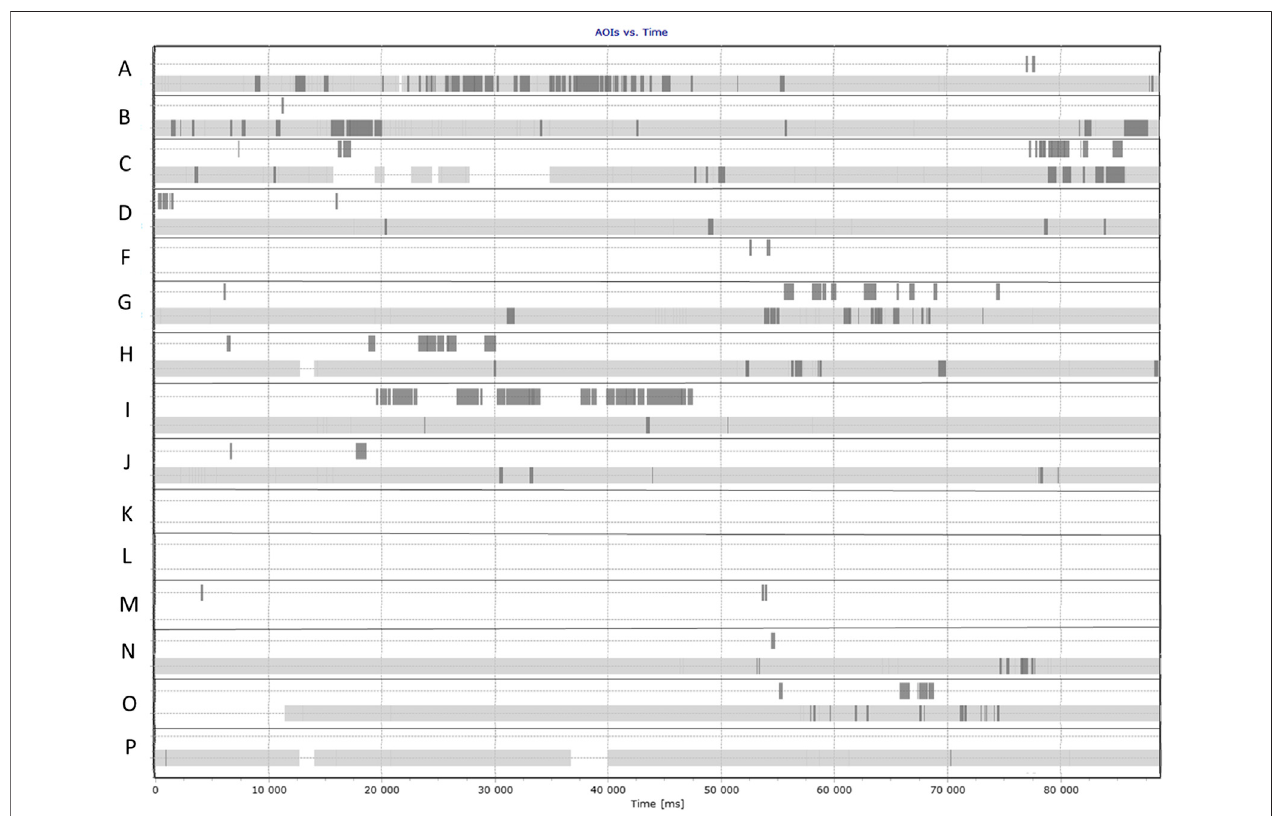
FIGURE 4 | Combined graph AOI vs. time. Note: Each letter corresponds to one pupil. The fi rst line for each pupil is IN mode, the second is ON mode. Gray background in the second line shows that the AOI was visible, white background indicates the AOI was not visible at that